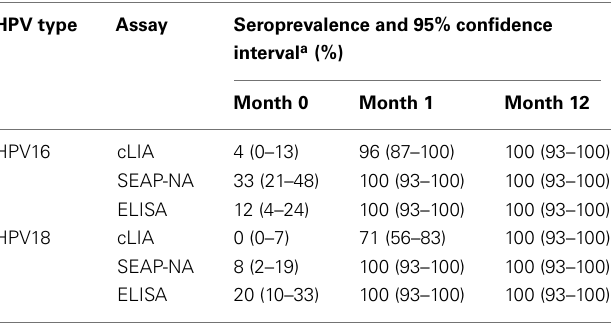
Table 1 | Seroprevalence by HPV type, assay, and visit among 51 women in the Costa RicaVaccineTrial